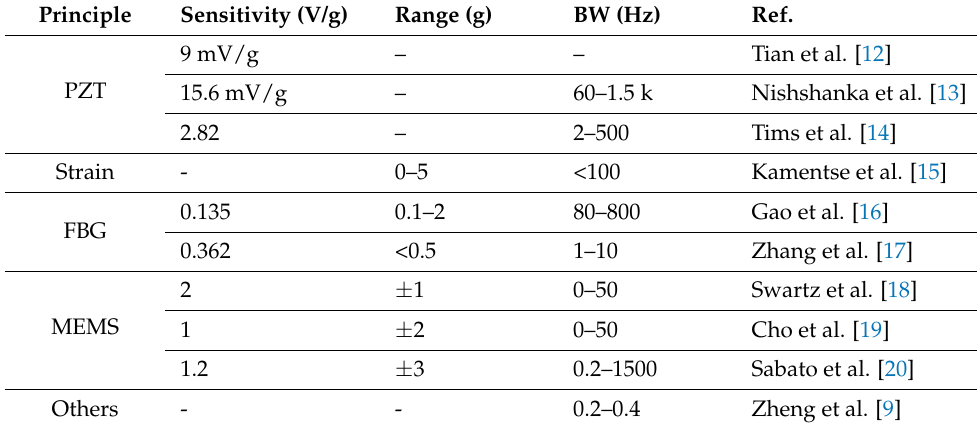
Table 1. Summary of accelerometers for low vibration